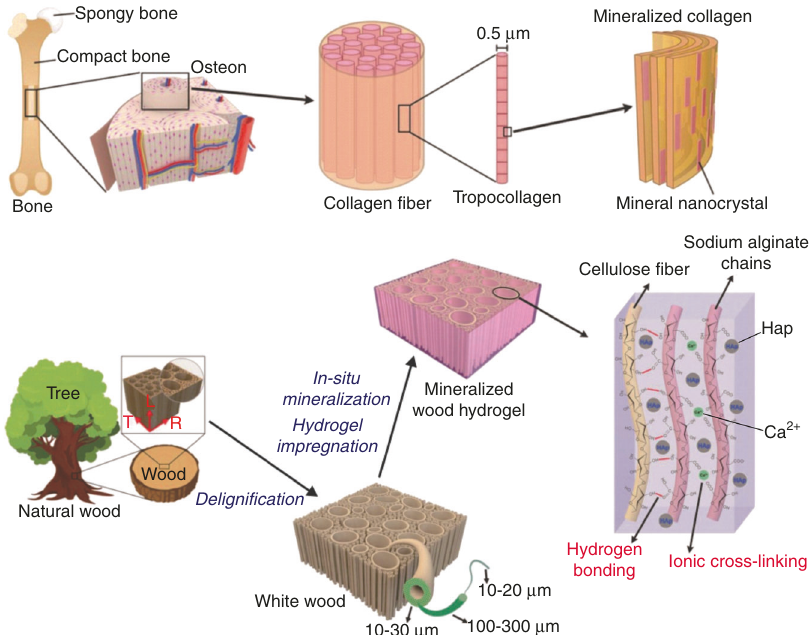
Fig. 2 Biomimetic strategy for preparing highly anisotropic, ultrastrong and stiff osteoconductive mineralized wood hydrogel composites. Figures adapted with permission from ref.